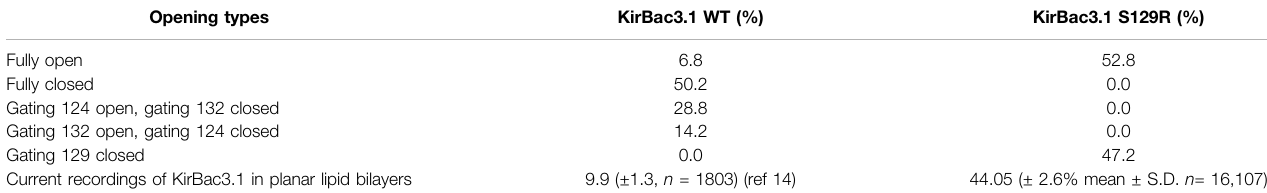
TABLE 1 | Populations (in percentage) of different opening states in the relaxed structures of KirBac S129R obtained through MDeNM simulations and single channel recording; comparison with KirBac3.1 WT is shown. Opening types